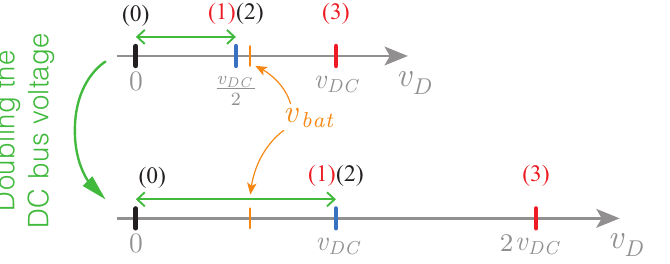
Figure 8. Available voltage values and operating area (in green) of the 3LDC converter, when the DC bus voltage is doubled, with an OC fault in outer IGBT S D 1